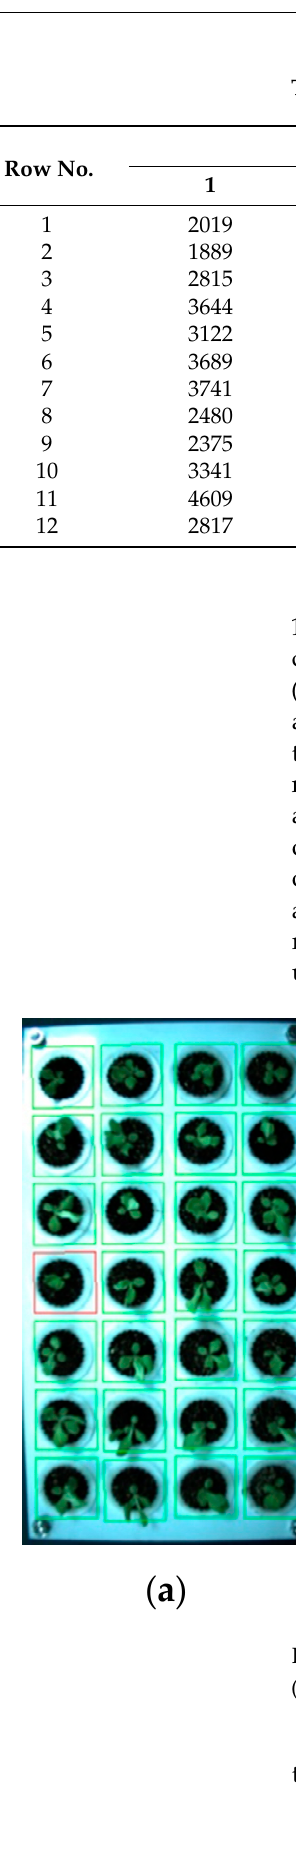
necting the pixel points of the leaf area, and the red line is the dividing line between qual- ified seedlings and unqualified seedlings, that is, the detection results at the lower part of the red line are unqualified seedlings. The distribution of pixel points is uneven, and the difference between the maximum value and the minimum value is obvious, indicating that the growth of leafy vegetable seedlings is quite different.